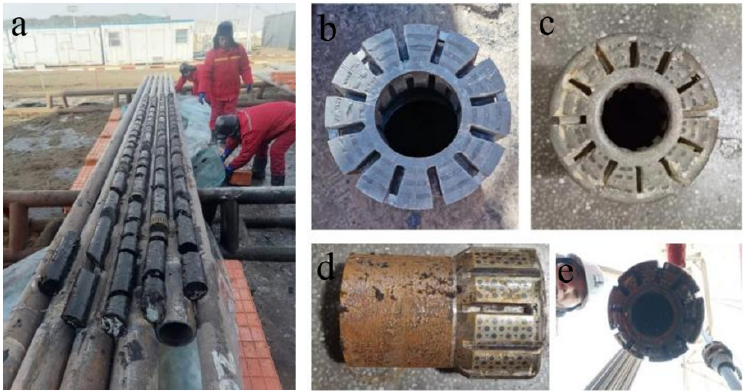
Figure 11. Drilling test of bionic core bit in hard rock. ( a ) Recovery core in the test; ( b ) Drill bit before the test; ( c ) Drill bit after the test; ( d ) Side view of the drill bit after testing; ( e ) Drill bit during lifting down.